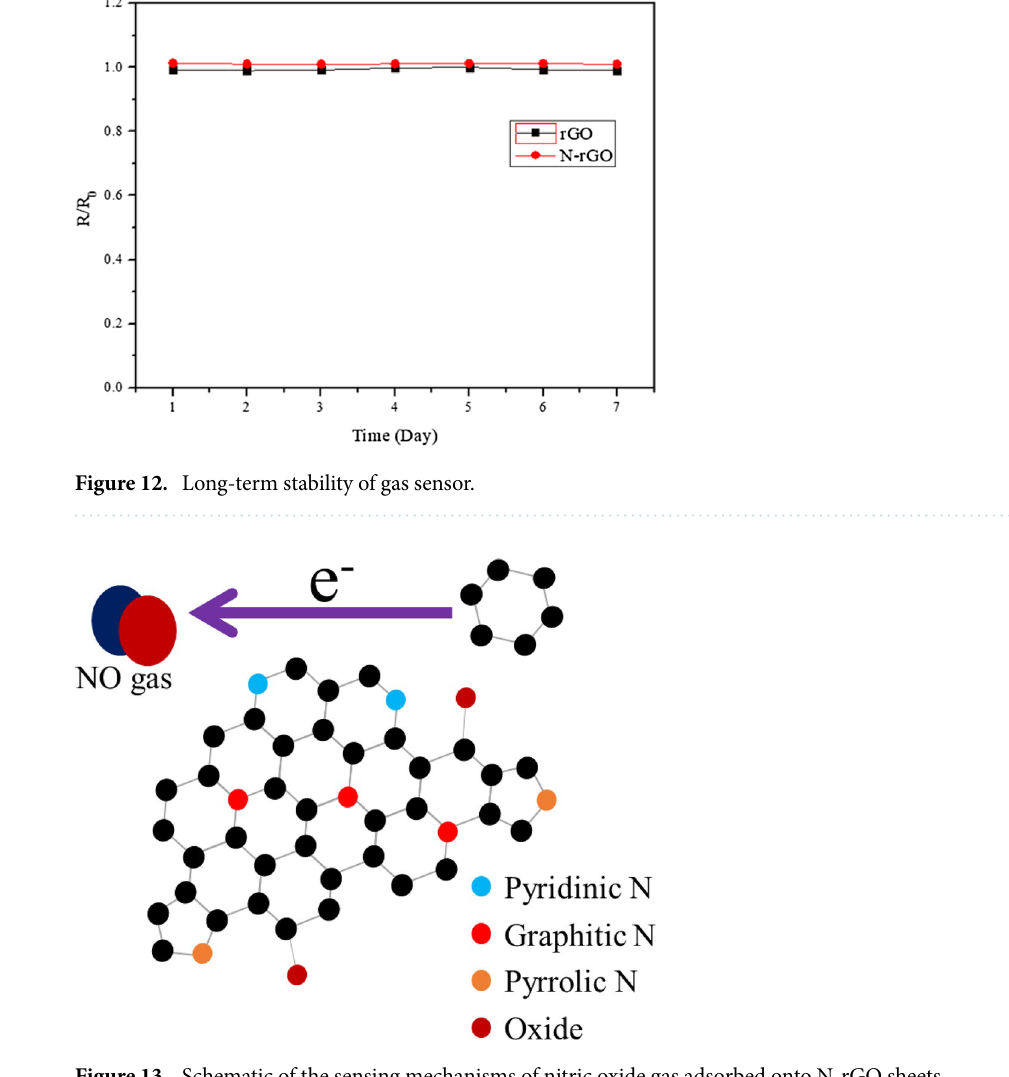
Figure 13. Schematic of the sensing mechanisms of nitric oxide gas adsorbed onto N-rGO